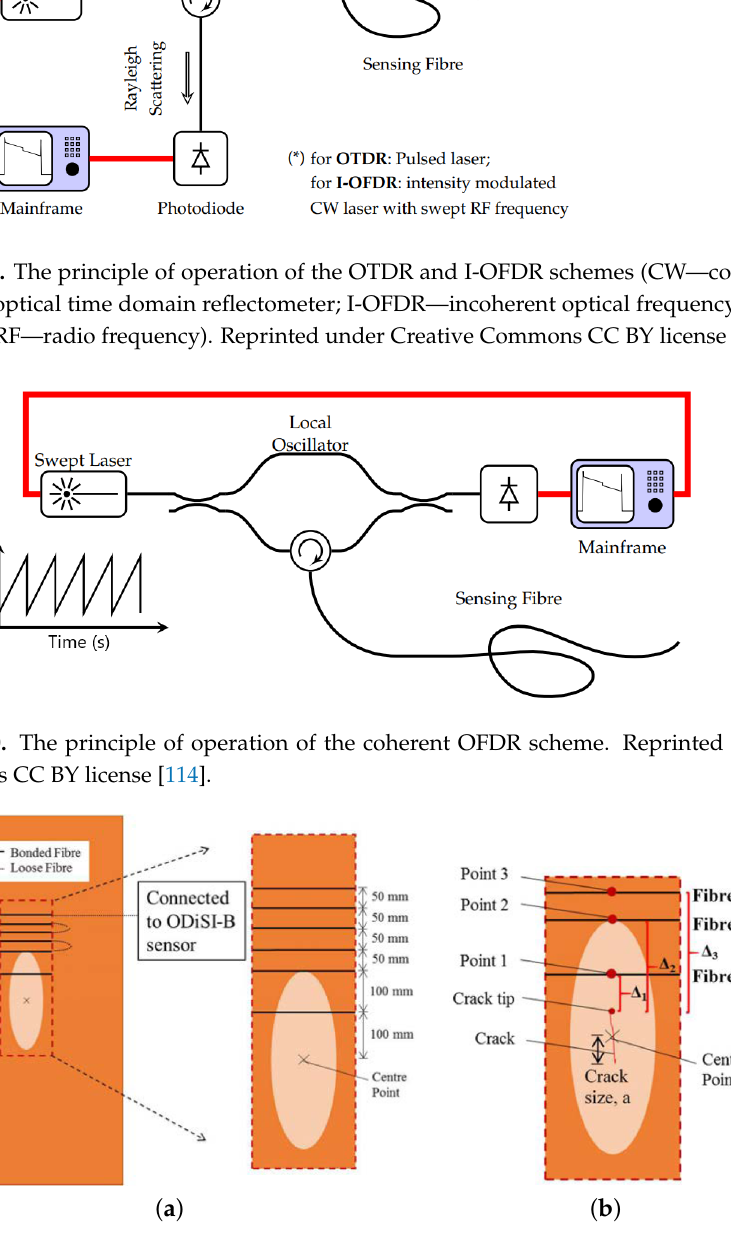
Figure 31. ( a ) Schematic drawing of the orientation of an optical fibre on the pipe specimen. ( b ) The position of the crack relative to the positions of the fibre rings. Reprinted under Creative Commons CC BY-NC-ND license